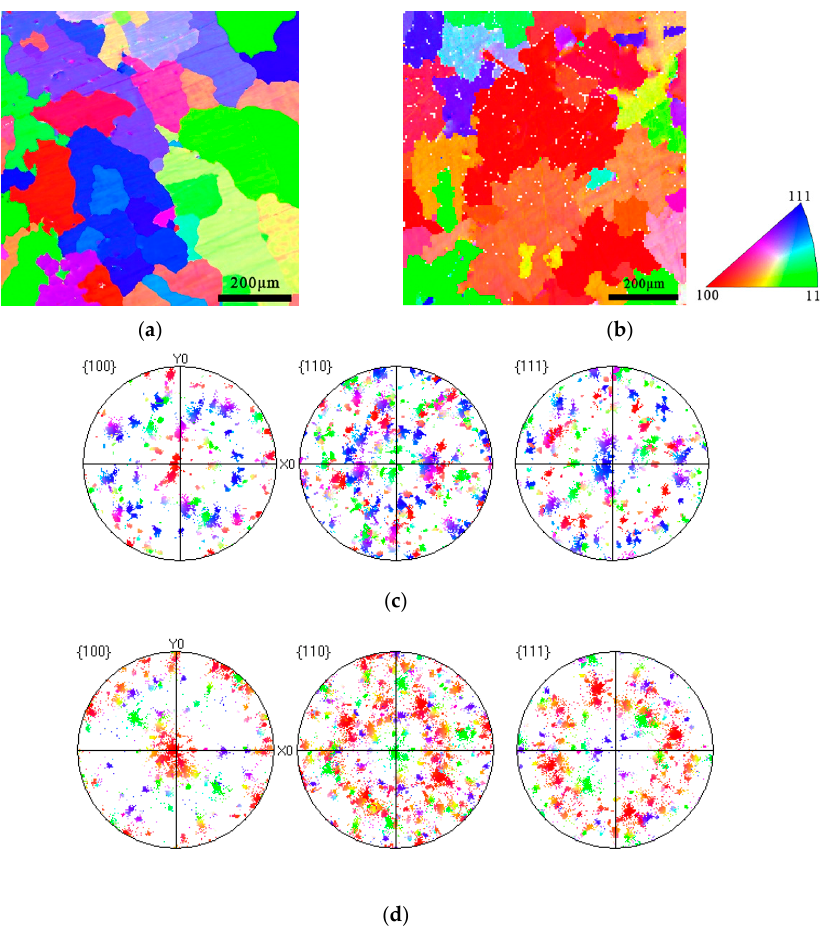
Figure 6. EBSD grain orientation of as-cast alloys: ( a ) Ir–6Al–13W and ( b ) Ir–6Al–13W–8Ta; Orientations maps of alloys from EBSD analysis: ( c ) Ir–6Al–13W and ( d ) Ir–6Al–13W–8Ta.